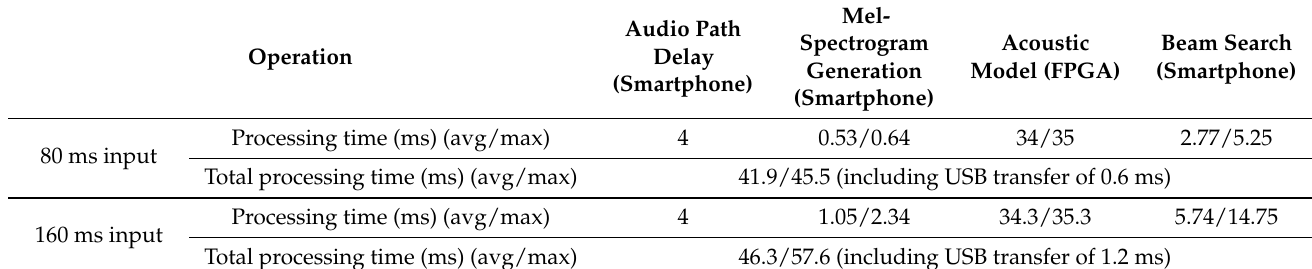
Table 14. Itemized processing times for 80 ms and 160 ms unit